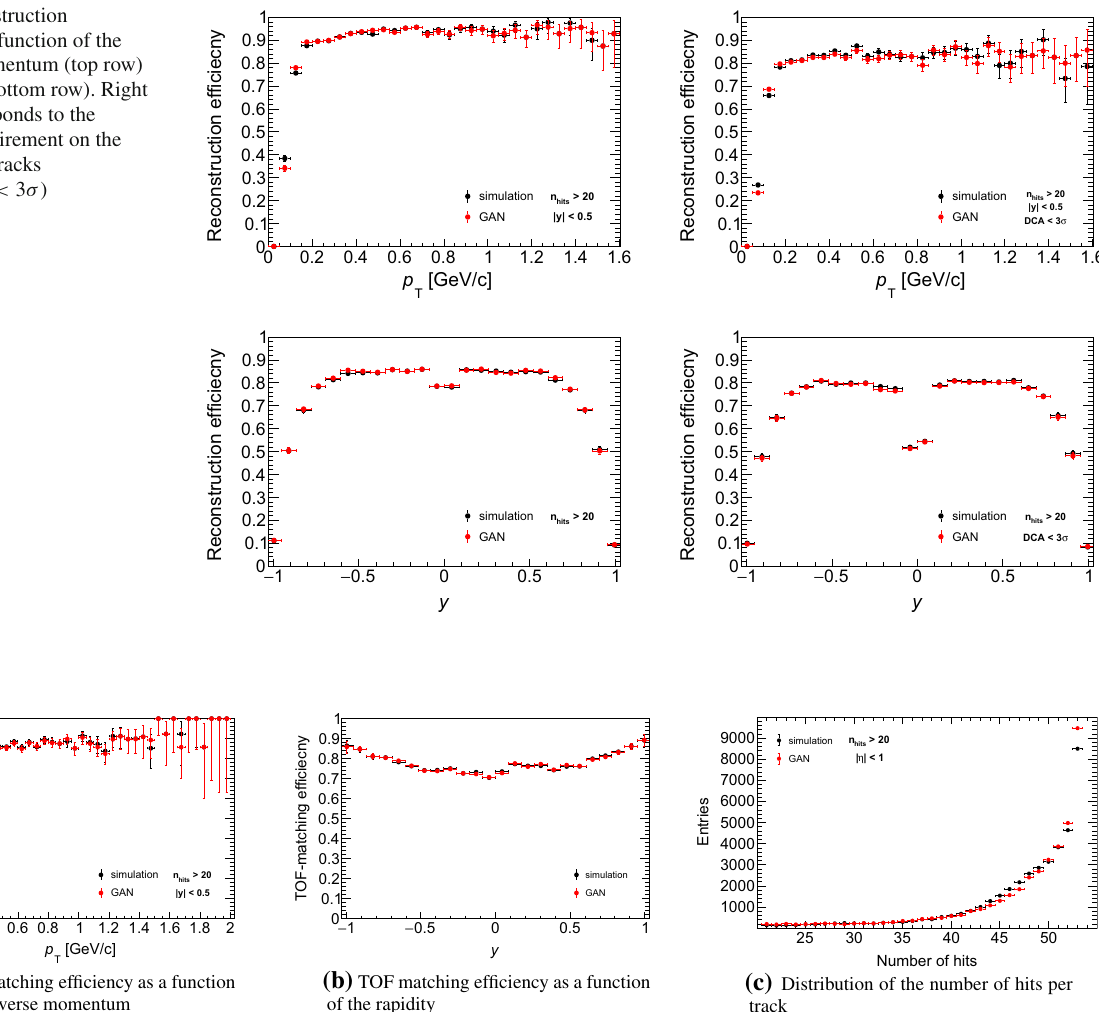
Fig. 7 TOF matching efficiencies over transverse momentum ( a ) and rapidity ( b ) and distribution of the number of hits per track ( c )